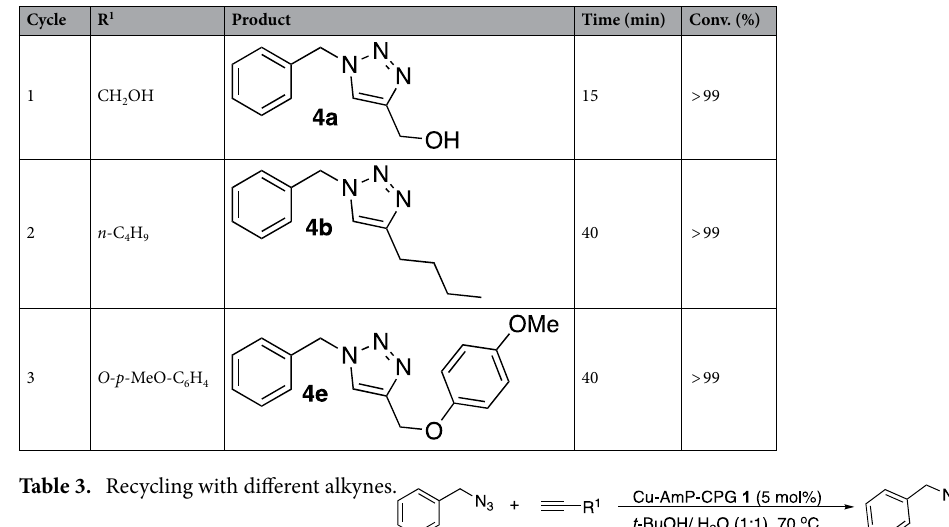
Table 3. Recycling with different alkynes.